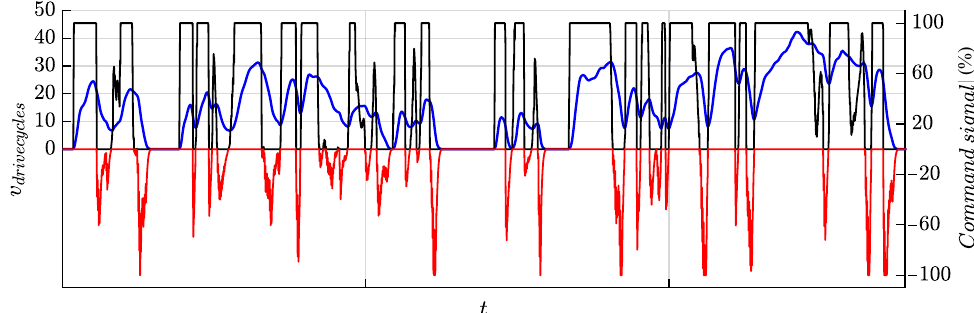
Figure 3. Input speed profile (blue), command signal (black), and acceleration/deceleration signal in-